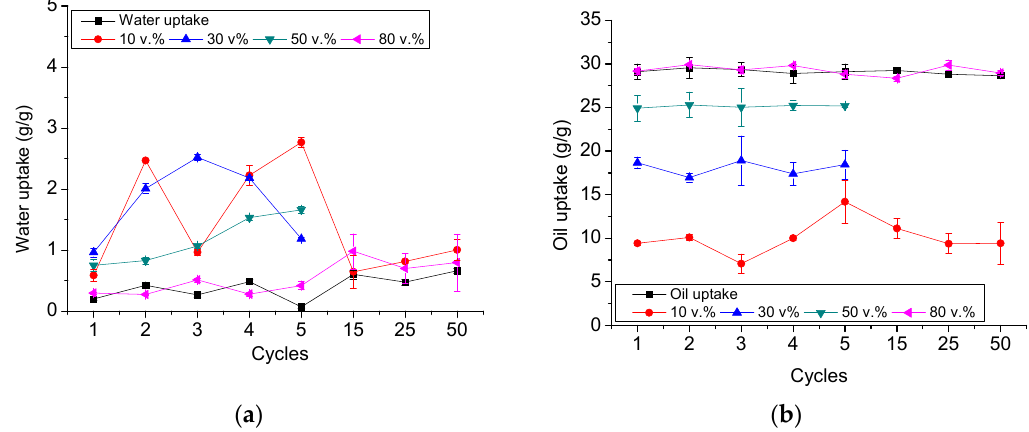
Figure 3. Simultaneous ( a ) water (w water ) and ( b ) oil uptakes (w oil ) of PUT foams from stable water-in-oil emulsions up to 50 absorption/washing cycles.